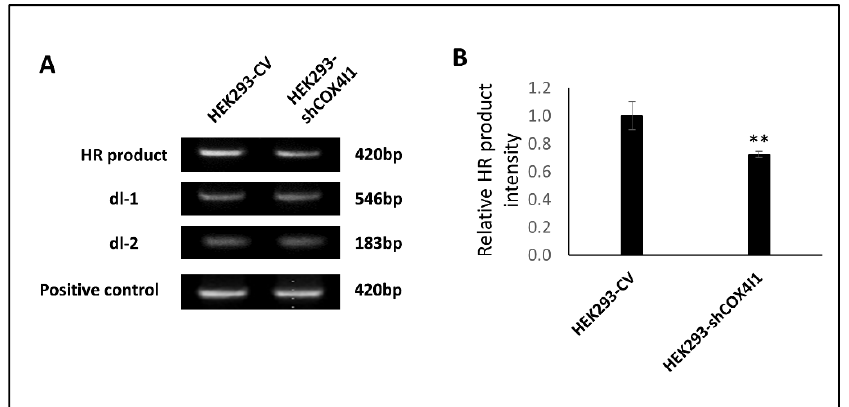
Figure 3. DNA damage recovery following etoposide (EP) treatment is less efficient in COX4-1-deficient cells. ( A , C ) Both COX4-1-deficient cells (HFF-shCOX4I1 and patient) and their corresponding controls (HFF-CV and healthy control) from similar passages were seeded in equal numbers overnight on tissue culture slides and, the following day, were exposed for 1 h to 100 µ M etoposide (EP). Following 2 or 24 h of recovery, the cells were stained for DSBs anti- γ H2AX antibody (green). Nuclei were visualized by Hoechst-3334 (blue), and the quantity of DSB foci per nucleus was analyzed and compared to untreated cells (UT) and respective controls. The micrographs were quantified and depicted as histograms ( B , D ) that show the γ H2AX foci number per nucleus relative to t = 0 (meaning untreated cells) ± SEM of at least 100 nuclei, * p < 0.05, *** p < 0.001. The results suggest that both COX4I1-deficient cells showed impaired ability to respond and thereby to recover from DNA damage, while the controls exhibited an almost complete recovery 24 h after the exposure.